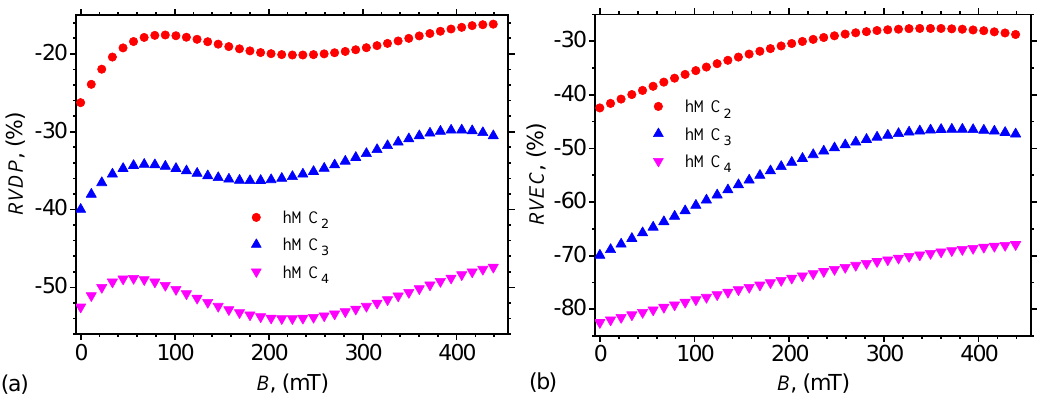
Figure 13. Relative variation of dielectric permittivity ( a ), and of electrical conductivity ( b ) of hMCs with CI and µ F with magnetic flux